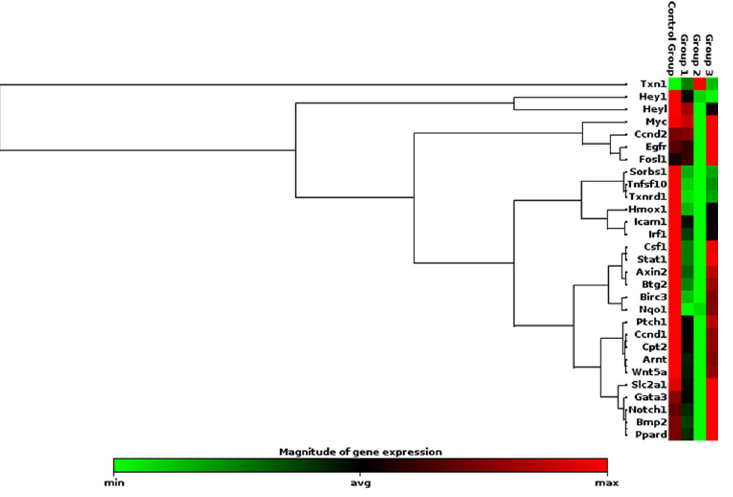
Fig 11. Clustergram of genes expressed significantly following 532 nm laser exposure at moderate irradiance of 0.25 W/cm 2 .